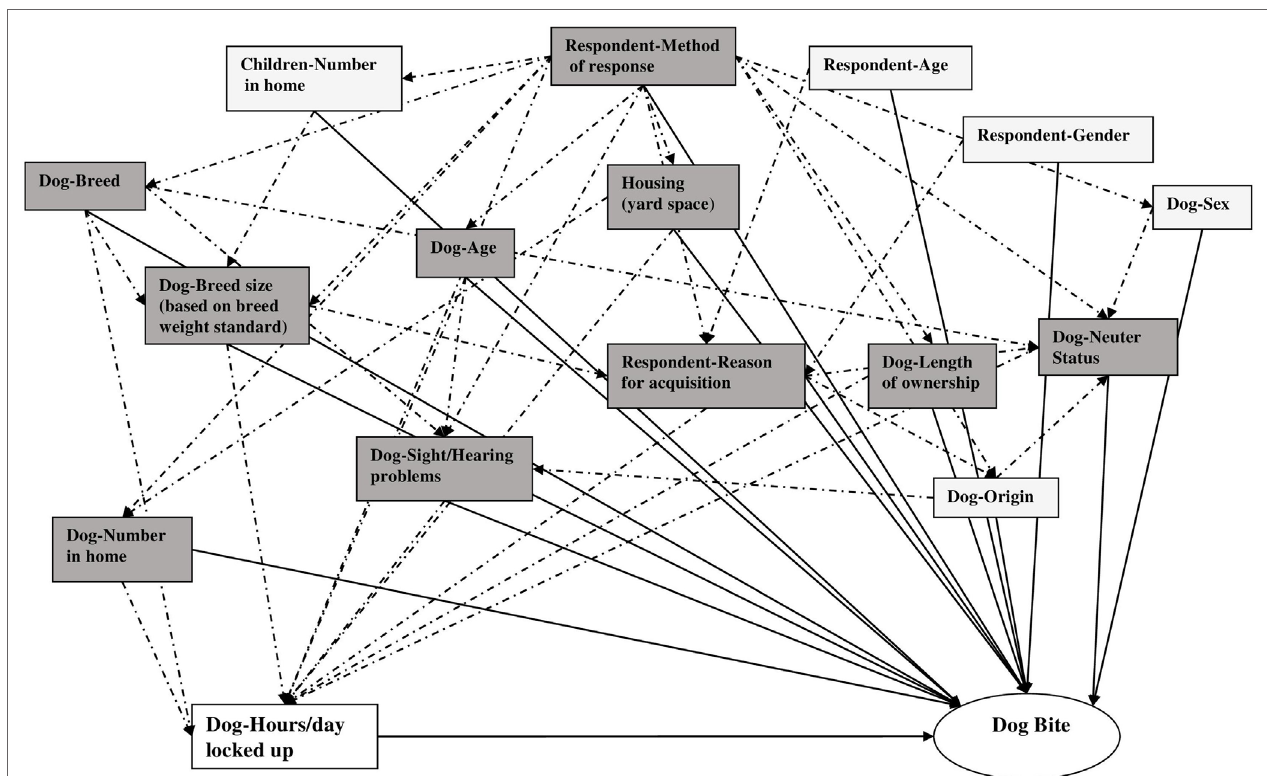
FigUre 2 | Directed acyclic graph used to select a minimally sufficient set of potential confounders for control of the association of “Number of hours per day locked in kennel, crate or room” with dog bites to the family child. Solid lines represent hypothesized causal relationships between exposures and dog bites. Dotted lines represent hypothesized causal relationships between exposures. All shaded boxes together form a sufficient set of variables for confounder control. All darkly shaded boxes together form a minimally sufficient set of variables for confounder